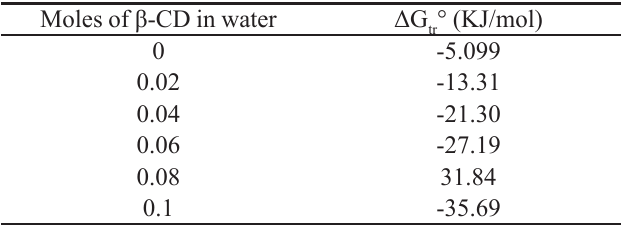
TABLE II - Gibbs free energy of transfer (ΔG process of nifedipine in aqueous solutions of β-CD at 37 °C.